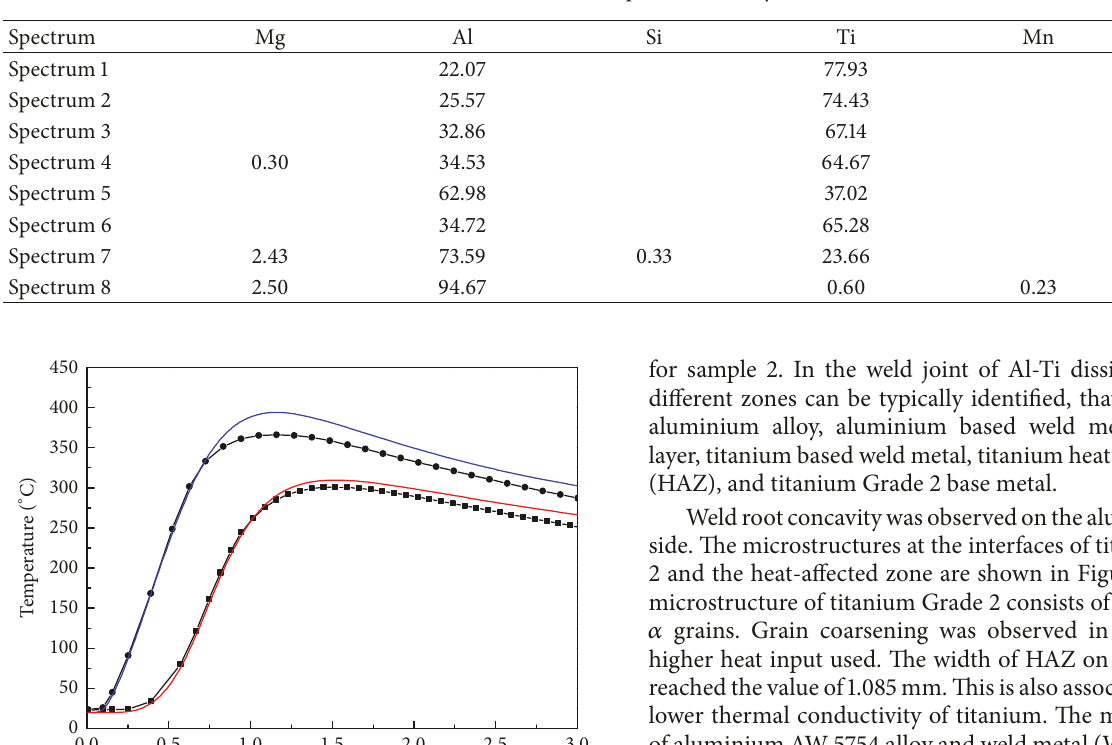
Table 4: Results of point EDX analysis.